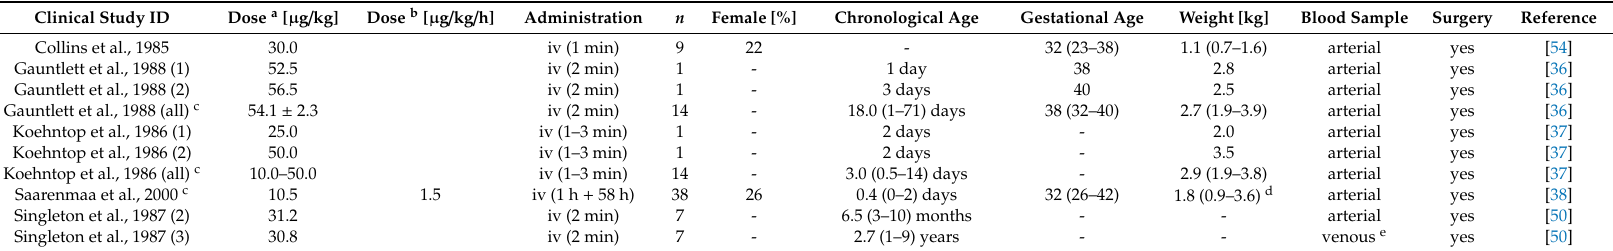
Table 2. Overview of clinical studies used for evaluation of the pediatric PBPK model predictions of fentanyl. Clinical Study